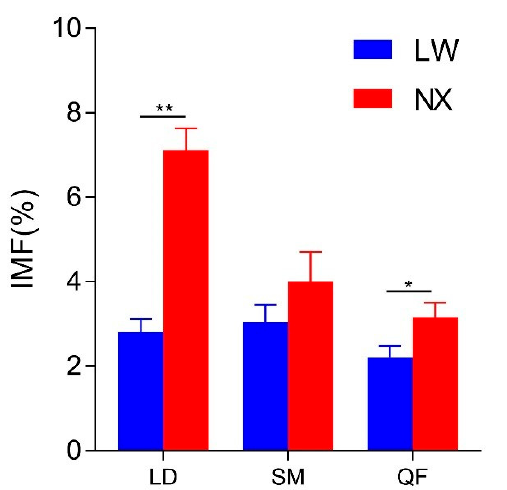
Figure 1. Intramuscular fat content of muscle between the two breeds. LD, longissimus dorsi muscle; SM, soleus muscle; QF, quadriceps femoris muscle. LW, Large White; NX, Ningxiang. ∗ indicates significant difference at p < 0.05, ∗∗ indicates significant difference at p < 0.01.